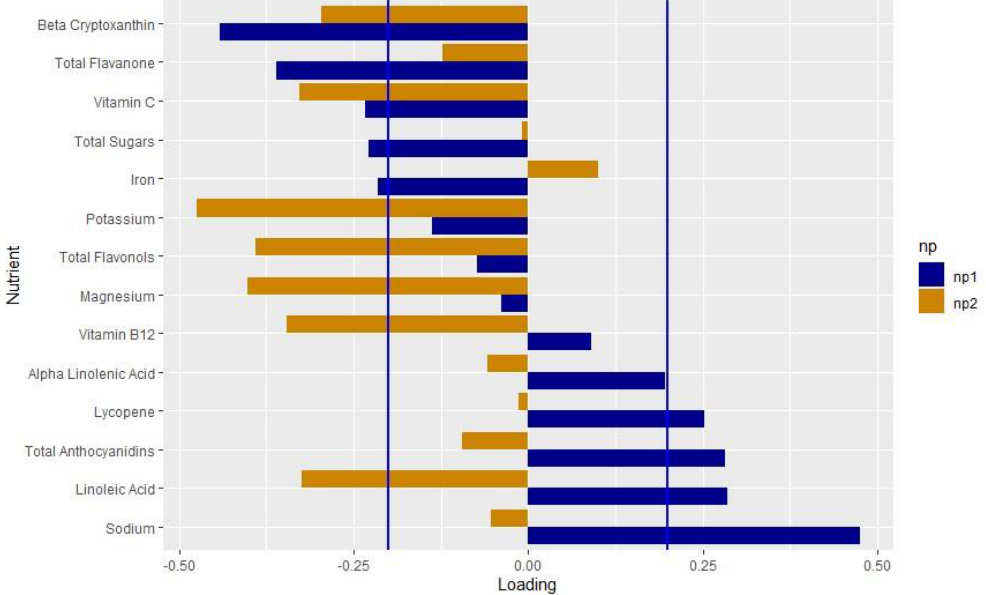
Figure 2. Loadings of the nutrient pattern: Loading values from the nutrient patterns extracted using reduced rank regression with genetically adjusted oxylipin PC1 and PC2 as the response variables. The nutrients are listed on the y -axis and the loading value is indicated on the x -axis. Blue bars indicate the loading values for NP1; orange indicates values for NP2. Blue lines mark the cutoff of the nutrients that load importantly, >|0.2|.